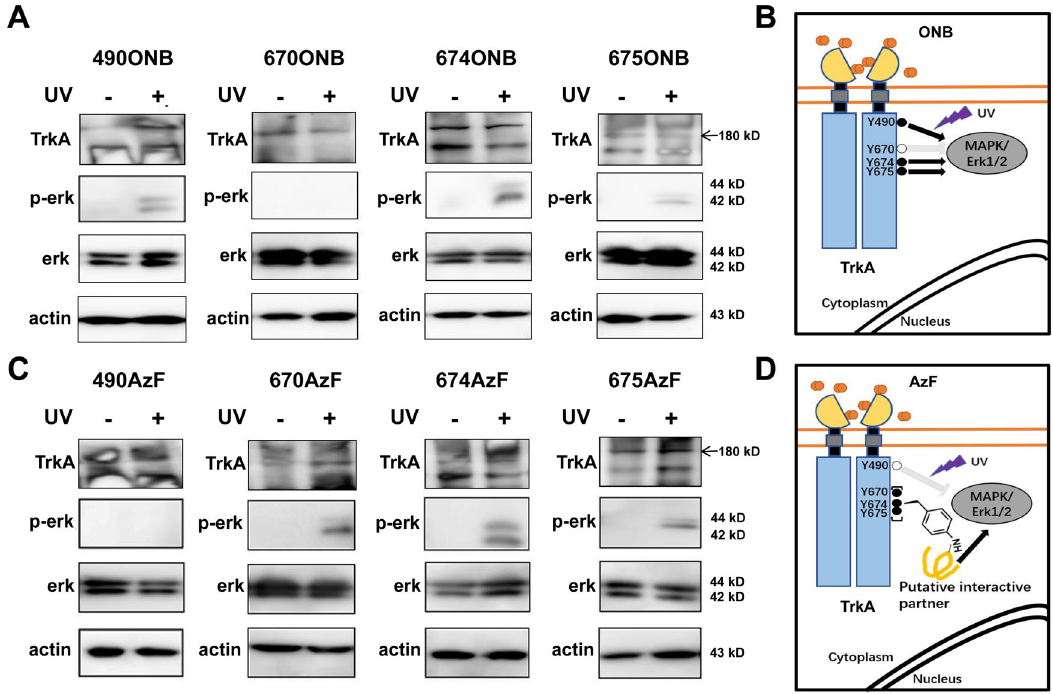
Fig. 4 UV light activates MAPK/ERK signaling pathway by site-speci fi cally incorporated AzF and ONB in TrkA. a Western blot analysis of HEK293T cells expressing ONB mutants for phosphorylated ERK (Thr202 and Tyr204) in the presence of ligand NGF without ( − ) or with ( + ) UV light. b Binding of the NGF drives TrkA dimerization, autophosphorylation and initiates intracellular MAPK/ERK. In the presence of ligand NGF, ONB incorporated at the Y490, Y674, and Y675 (solid circles) sites in TrkA, respectively, after UV treatment initiate intracellular MAPK/ERK signaling (arrows). ONB incorporated in Y670 (empty circle) site does not initiate intracellular MAPK/ERK signaling (inhibited arrow) c Western blot analysis of HEK293T cells expressing AzF mutants for phosphorylated ERK (Thr202 and Tyr204) without ( − ) or with ( + ) UV light. UV photolysis was done with 365 nm UV cross- linker CL-1000L (Analytik Jena) at 40w for 5 min at 4 °C. TrkA and β -actin were used as loading control. d Binding of the NGF drives TrkA dimerization, autophosphorylation and initiates intracellular MAPK/ERK. In the presence of ligand NGF, AzF incorporated at the Y670, Y674, and Y675 (solid circles) sites in TrkA, respectively, after UV treatment initiate intracellular MAPK/ERK signaling (arrows) presumably due to the crosslinking with a putative interactive protein. AzF incorporated in Y490 (empty circle) site does not initiate intracellular MAPK/ERK signaling (inhibited